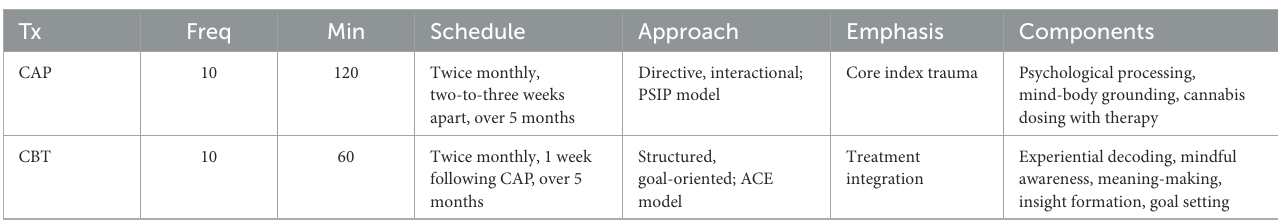
TABLE 1 Psychotherapeutic regimens.